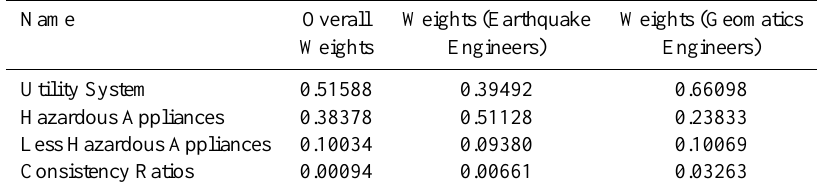
Fig. 4. Structure of AHP for post-earthquake ignition. Table 2. Weights for the main components of post-earthquake